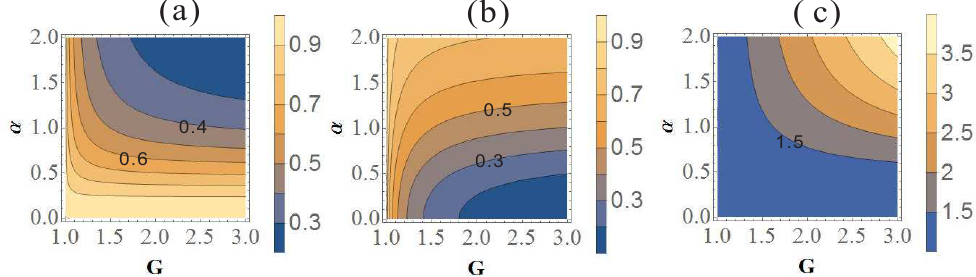
Figure 3. The dependence of E s 1 ( a ), E s 2 ( b ), and E 12 ( c ) on the gain G and interaction strength ratio α